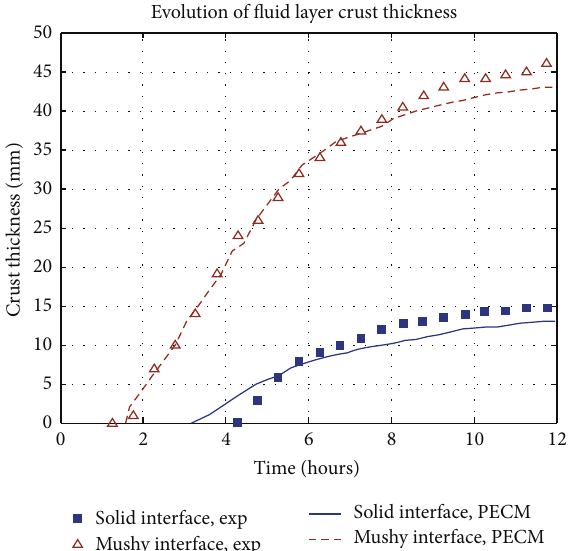
Figure 15: Evolution of PECM predicted and experimental crust thickness (solid and mushy), mushy velocity model 𝑈 𝑀 = 𝑈 combined convection with 𝑟 𝐶 =